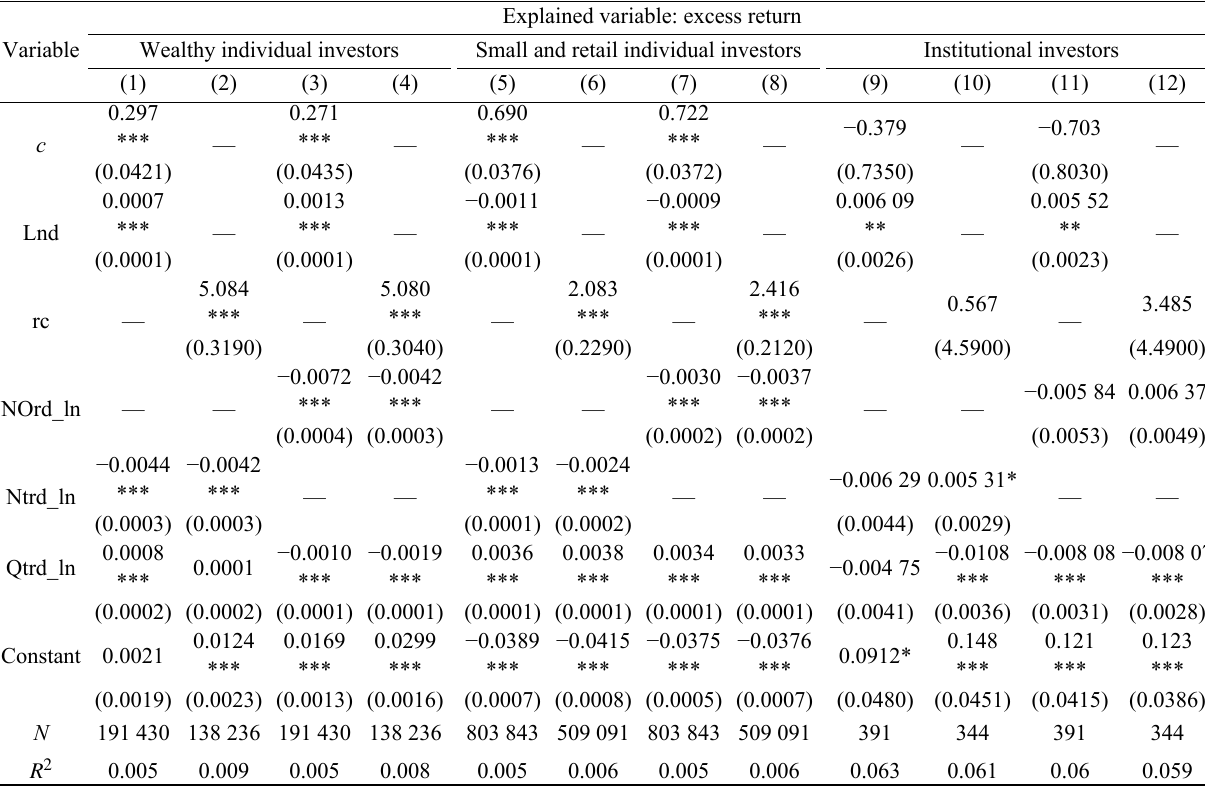
Table 10 Analysis of investment behavior of heterogeneous investors based on social network. Explained variable: excess Variable